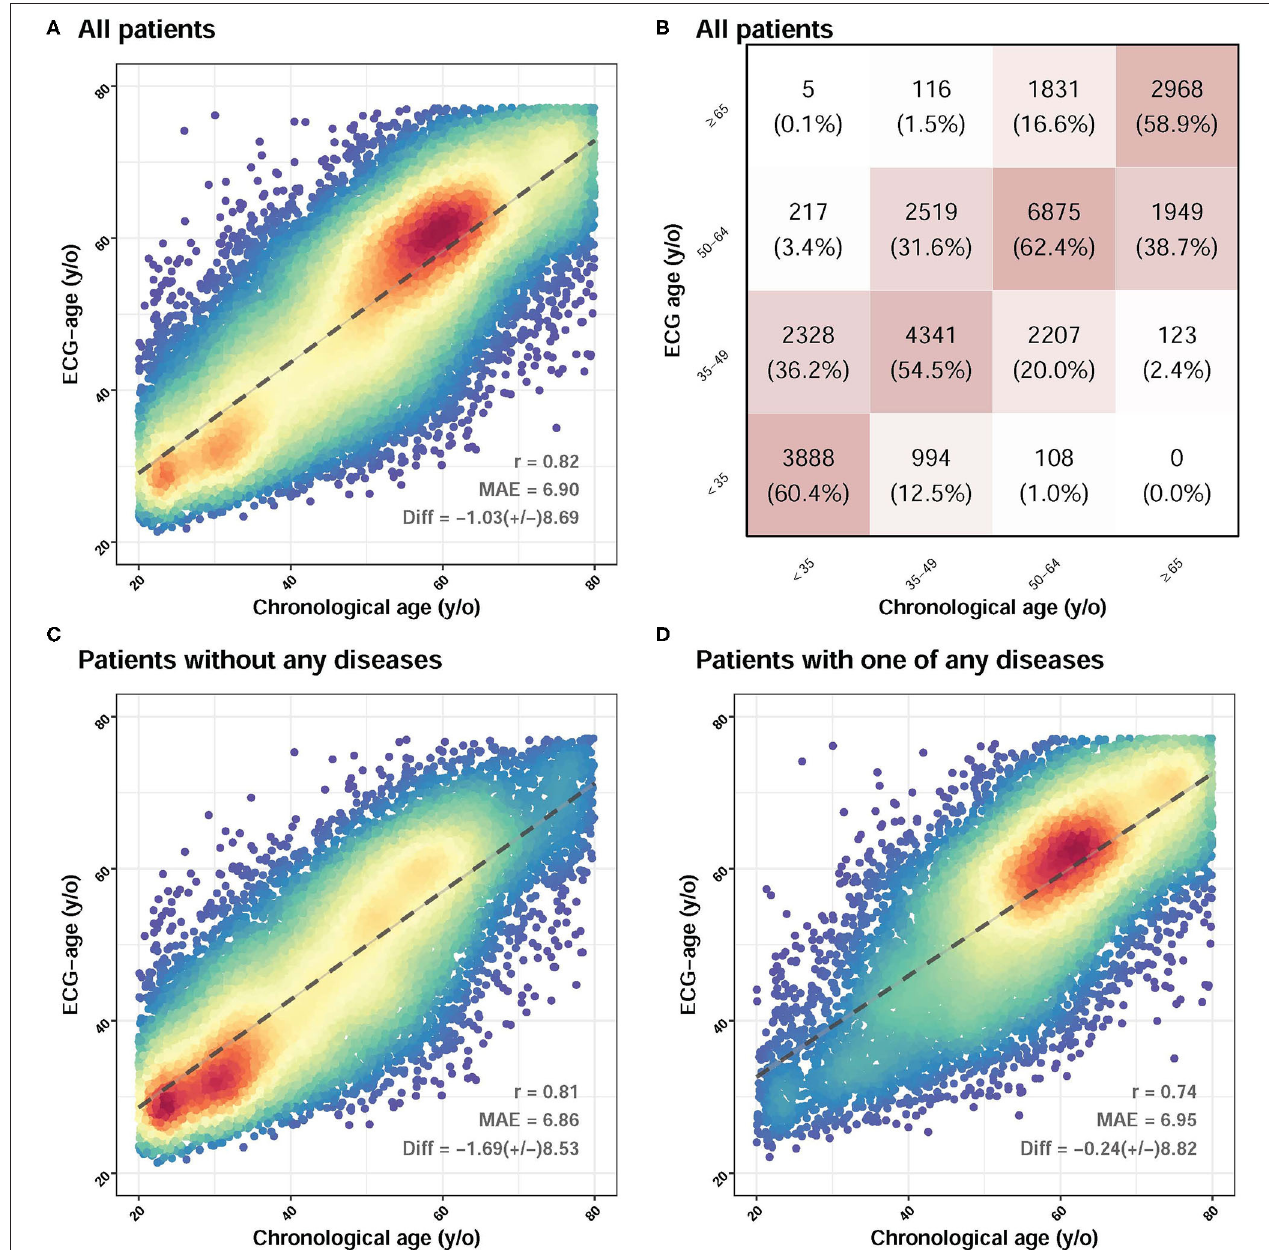
FIGURE 3 | The association between chronological age and ECG-age in validation set. (A) Shown is the ECG age (y-axis) vs. the reported chronologic age (in years; x-axis, dotted line). The difference between chronologic age and ECG-age was 1.03 ± 8.69 years with a mean absolute error of 6.899 years. (B) It demonstrates a multi-group classification to the age (in years). There are 16 groups which divided by ECG age and chronologic age. The y-axis is ECG age and the x-axis is chronologic age. Each group is in terms of the percentage of patients with a specific chronologic age who had a specific corresponding ECG-age (eg, a patient from < 35 y of age having a ECG age from < 35 y). The squared weighted kappa value was 0.76 in this analysis. (C) Shown a subgroup analysis about patient without any diseases. The difference between chronologic age and ECG-age was 1.69 ± 8.53 years with a mean absolute error of 6.86 years. (D) Shown a subgroup analysis about patient with one of any diseases. The difference between chronologic age and ECG-age was 0.24 ± 8.82 years with a mean absolute error of 6.95 years. The MAE is highest in patient with any one of disease.